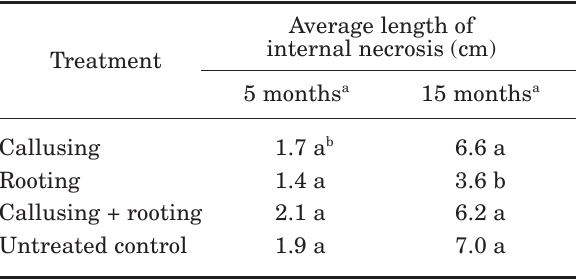
Table 1. Effects of Trichoderma applied at various nurs- ery-vine growth stages on Phaeomoniella chlamydospo- ra inoculated in the trunks of TR3T/K5BB grapevines 10 weeks after planting in PVC pots.